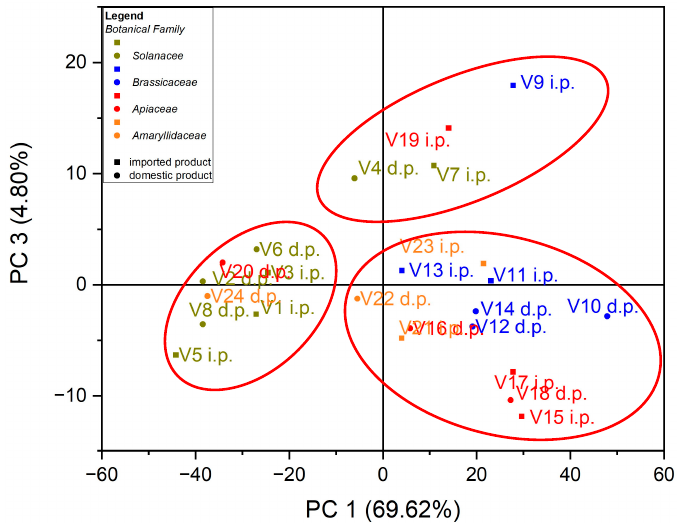
Figure 5. Chart of scores for PC3 vs. PC1 for PCA analysis, using as input data the content of trace elements for the analyzed vegetable samples.